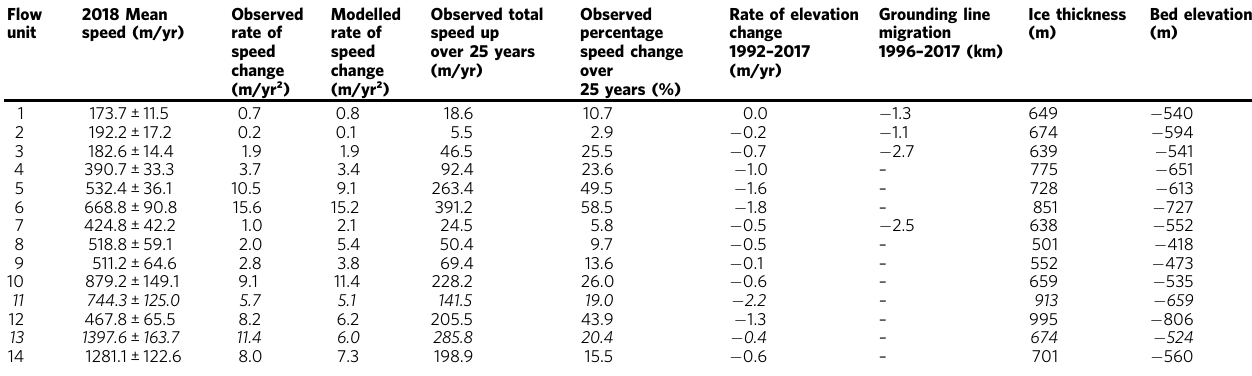
Allmeasurements were extractedfrom a 5-km-diameterregion at the groundingline, onall14 fl ow lines(Fig. 1a) in the Getz studyregion. Measurements of grounding linemigrationare provided where observations exist,along withthe mean FDM corrected icethickness and bed elevation 32 alsoextracted from the 5km region at the groundingline. Ice sheetelevationchange 8 was extracted from a 20- km-diameter region due to the coarser spatial resolution of this dataset. Italics denote fl ow units (11 and 13) with less than 70% coverage in the 5km region on the observed speed change map. Grounding line migration is calculated as the distance along the central fl ow line the grounding line has moved, negative indicating a movement